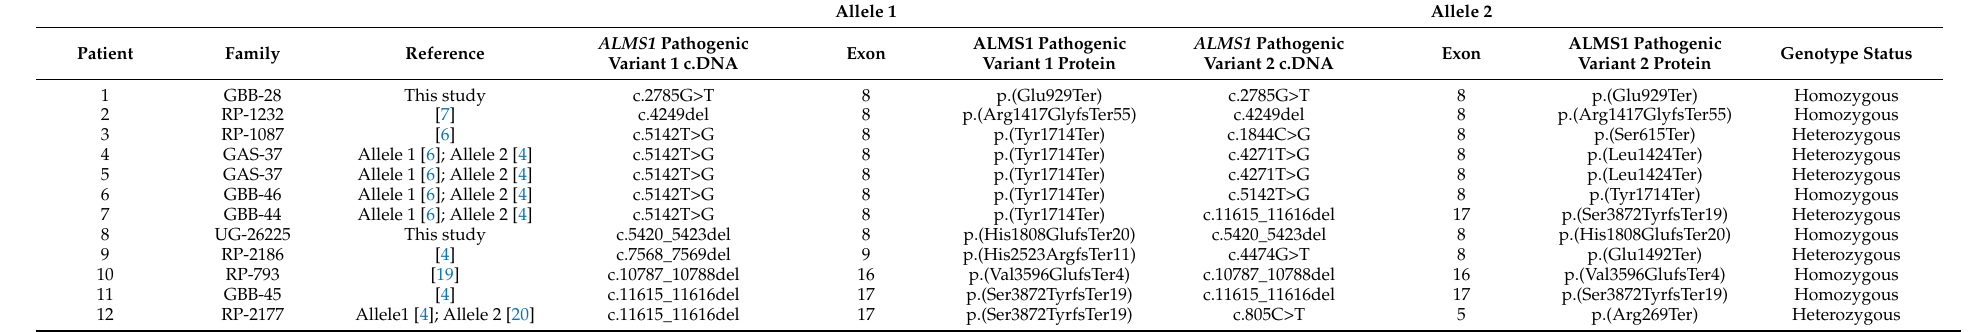
Table 1. Summary of the genotype of patients, their author reference, and the family and patient codes. The reference sequence for ALMS1 (ENST00000613296.5/ ENSP00000482968.1) was used.